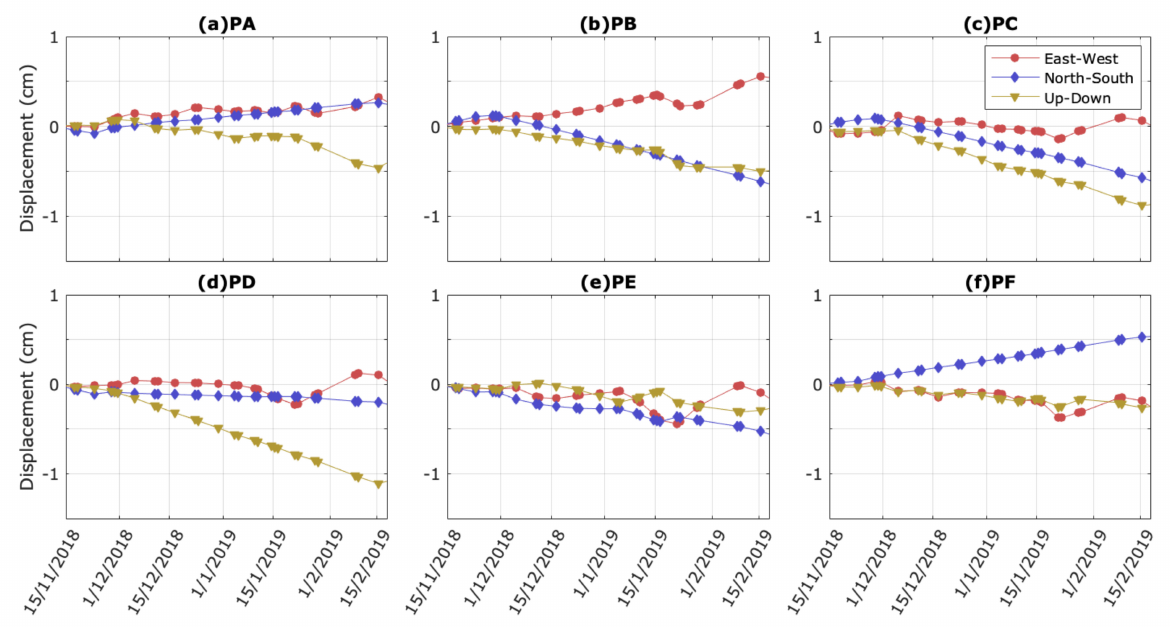
Figure 7. (a – f) East-West, North-South, and Up-Down deformation components of point locations indicated in Figure